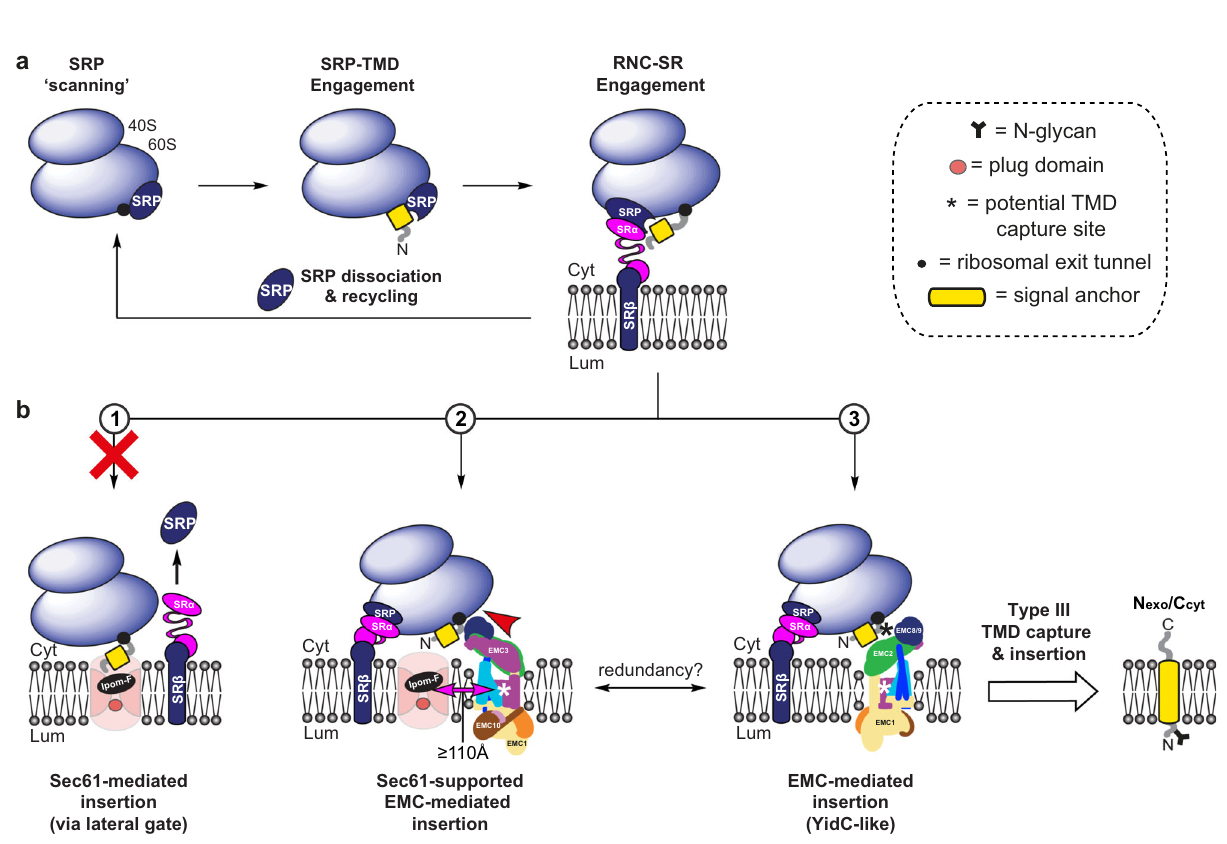
Fig. 7 A model for type III TMP biogenesis. a Type III TMPs are fi rst delivered to the ER membrane via the SRP-dependent co-translational pathway (as in Fig. 6). b Following engagement of SRP-SR α , we propose that the Sec61 complex may act as a ribosome docking site but, as opposed to the insertion of type I/II TMPs which proceeds via the lateral gate (route 1), Sec61 does not fully engage the transmembrane domain. Instead, the type III transmembrane domain is captured by the EMC and inserted into the membrane, most likely via the EMC3/EMC6 insertase site (route 2; pink and cyan coloured membrane-spanning subunits respectively); an action assisted by local thinning of the membrane 13 . This mechanism is not impacted by the binding of Ipom-F which, by analogy to mycoclactone 47 , impedes access to the Sec61 lateral gate. Alternatively, the Sec61 complex may support EMC-dependent translocation by facilitating the release of the SRP from the RNC-SRP-SR complex 36 , thereby permitting type III transmembrane domain capture by the EMC without ribosomal engagement of the Sec61 complex. Whilst the relative orientations of Sec61, the EMC and the ribosome-nascent chain complex are as yet unknown, such a mechanism would be consistent with the recent suggestion that steric limitations (see red arrow head) between a Sec61-engaged ribosome and the cytosolic domain of the EMC restrict the proximity of the Sec61 lateral gate and the EMC insertase site to ~110Å 12 (cf. double headed pink arrow). Alternatively, and/or additionally, the EMC may bind directly to ribosomes and insert type III transmembrane domains independently of the Sec61 complex, in a manner analogous to that of YidC (route 3). EMC schematics for route 2 and 3 are shown rotated 180° around the vertical axis in order to show potentially relevant EMC subunit locations. Potential sites of client transmembrane domain capture by the EMC are indicated, these may include: (i) a fl exible region of the EMC3/EMC6 insertase site (routes 2 – 3, white asterisk) and/or (ii) a hydrophobic cleft at the interface between EMC2-EMC8/9 (route 3, black